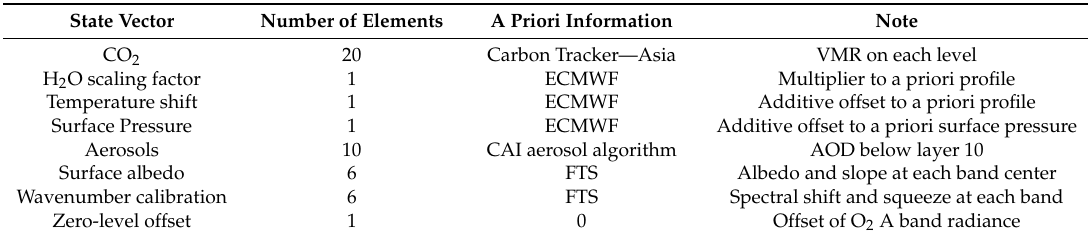
Table 1. Specification of state vectors and a priori